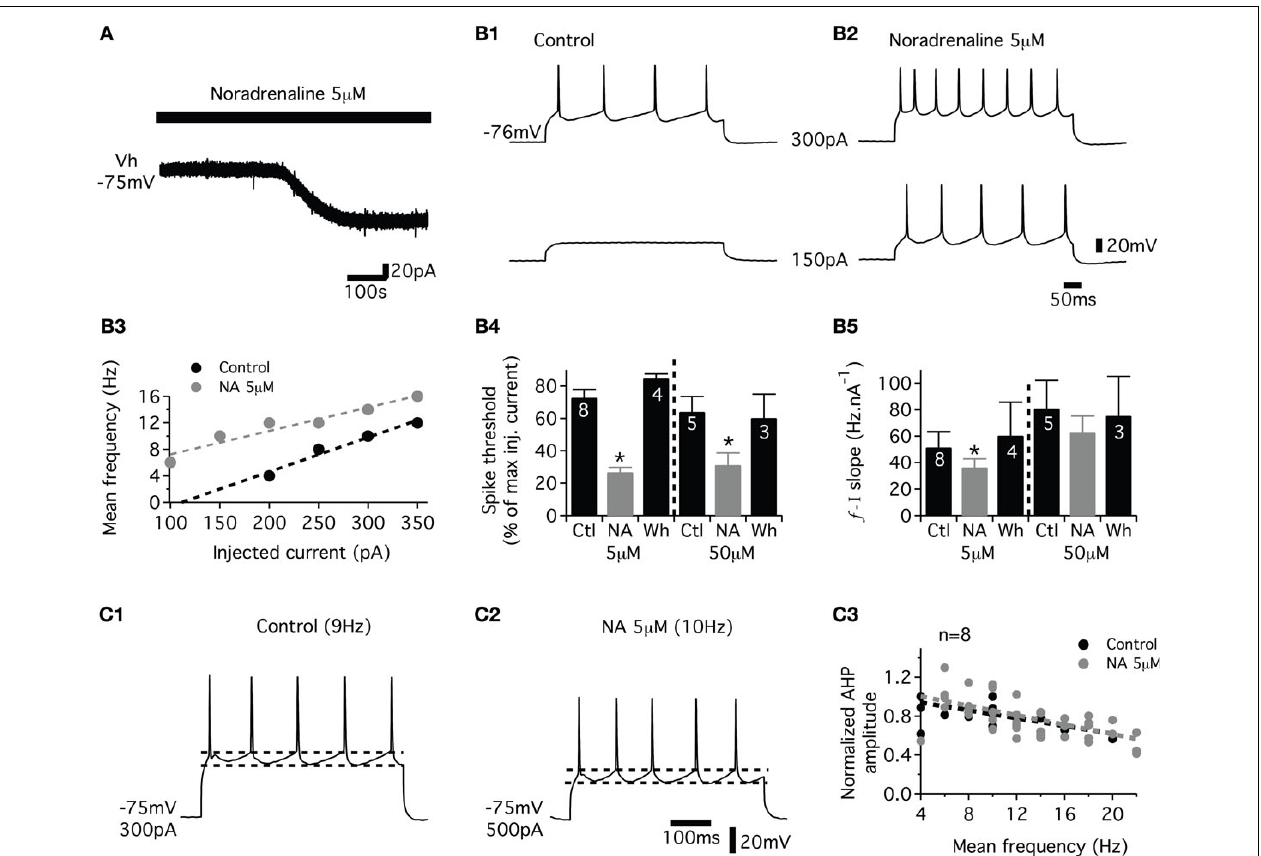
FIGURE 2 | Effects of noradrenaline (NA) on the membrane properties of the lumbar motoneurons. (A) Representative trace showing the NA-induced inward current in motoneurons held at − 75 mV (Vh). (B) A representative cell recording showing that NA increases the excitability and the spike frequency (B1,B2) in response to depolarizing current pulses. (B3) Plot of the mean spike frequency as a function of the injected current from the cell shown in (B1,B2) . (B4) The spike threshold computed as the percentage of the maximum injected current needed to evoke a spike during a series of depolarizing current steps in